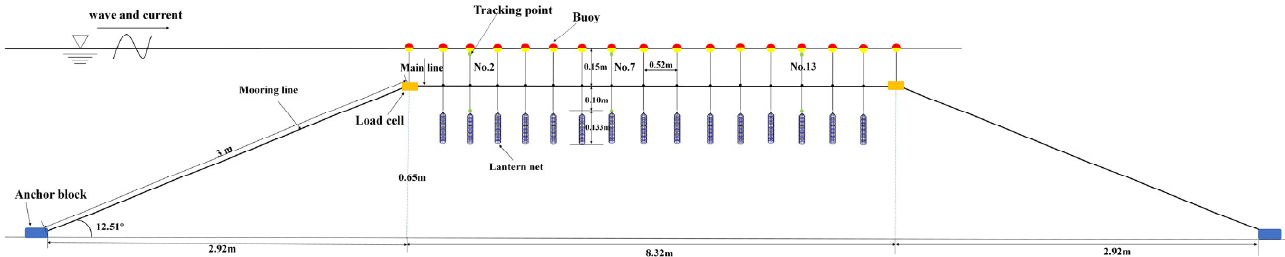
Figure 3. Schematic of single ‐ row longline aquaculture facility with lantern nets in the current/wave